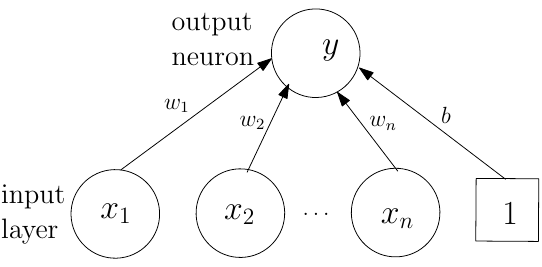
Figure 2. A single layer perceptron in the trained neural